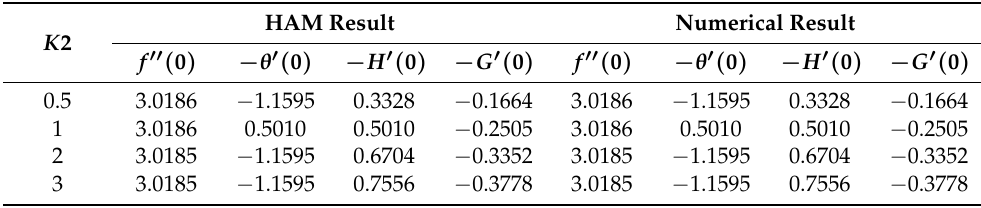
Table 12. Computational for f (cid:48)(cid:48) ( 0 ) , − θ (cid:48) ( 0 ) , − H (cid:48) ( 0 ) and − G (cid:48) ( 0 ) with S = − 0.5, P r = Ha = Sc = R = K 1 = 0.5, L = δ = 2, Q = 4 and differing values of K